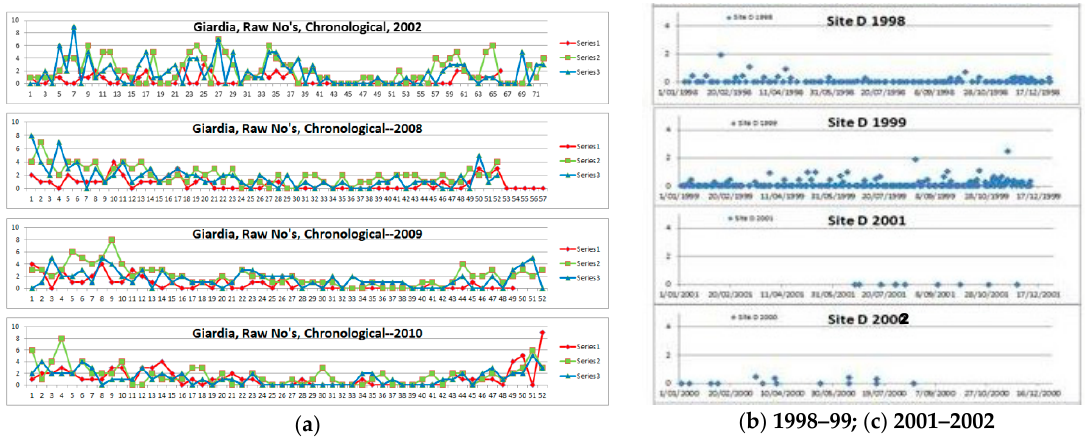
Figure 1. Typical C&G monitoring data: ( a ) 4 separate 1 year records of weekly Giardia measurements in 50 L samples from 3-related reservoir sampling sites ( b ) Cryptosporidium measurements in 10 L river water samples, weekly in 1998–1999; and ( c ) monthly in